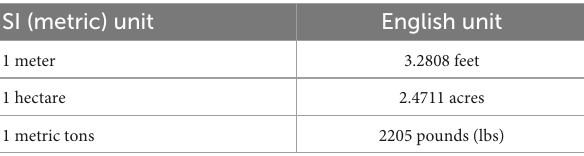
TABLE 1 Conversion factors from English to systems international (SI)-metric system of units (Source: Buffinton, 2023). SI (metric)